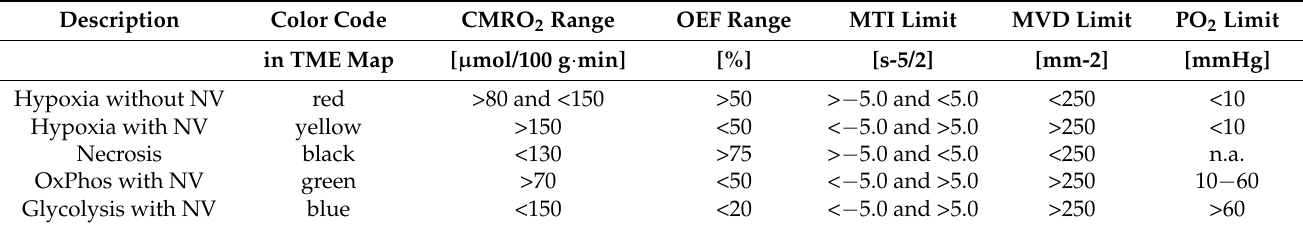
Table 3. Criteria for classification of TME